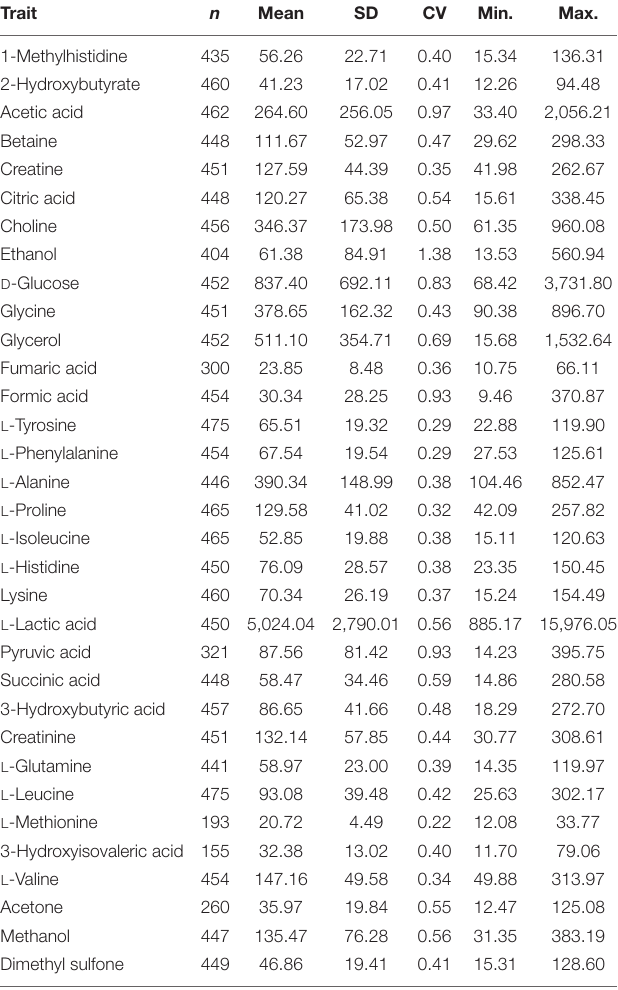
TABLE 1 | Descriptive statistics for 33 plasma metabolites: number of animals per metabolite ( n ), mean, standard deviation (SD), coefficient of variation (CV), minimum (Min.) and maximum